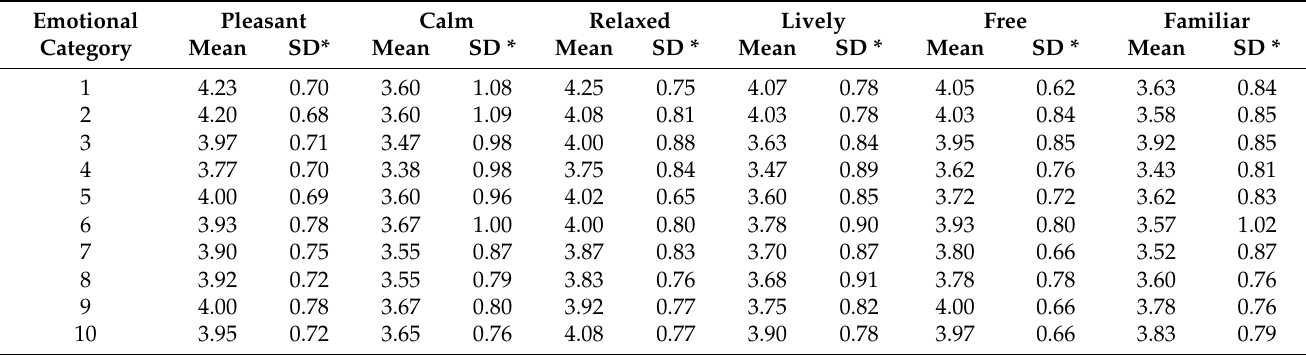
Table 13. Differences in positive emotion perception among samples.